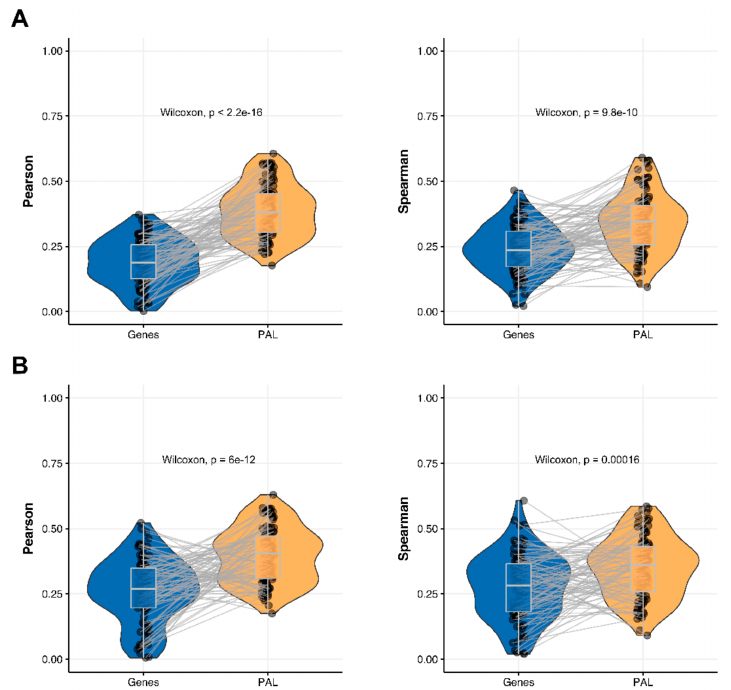
Figure 5. Paired gene-to-gene and PAL-to-PAL correlation between RNA and protein expression lev- els estimated within Glioblastoma Multiforme biosamples using Pearson ( left ) and Spearman ( right ) correlation coefficients for ( A ) the total set of genes and molecular pathways; ( B ) the set of drug target genes and molecular pathways [17].